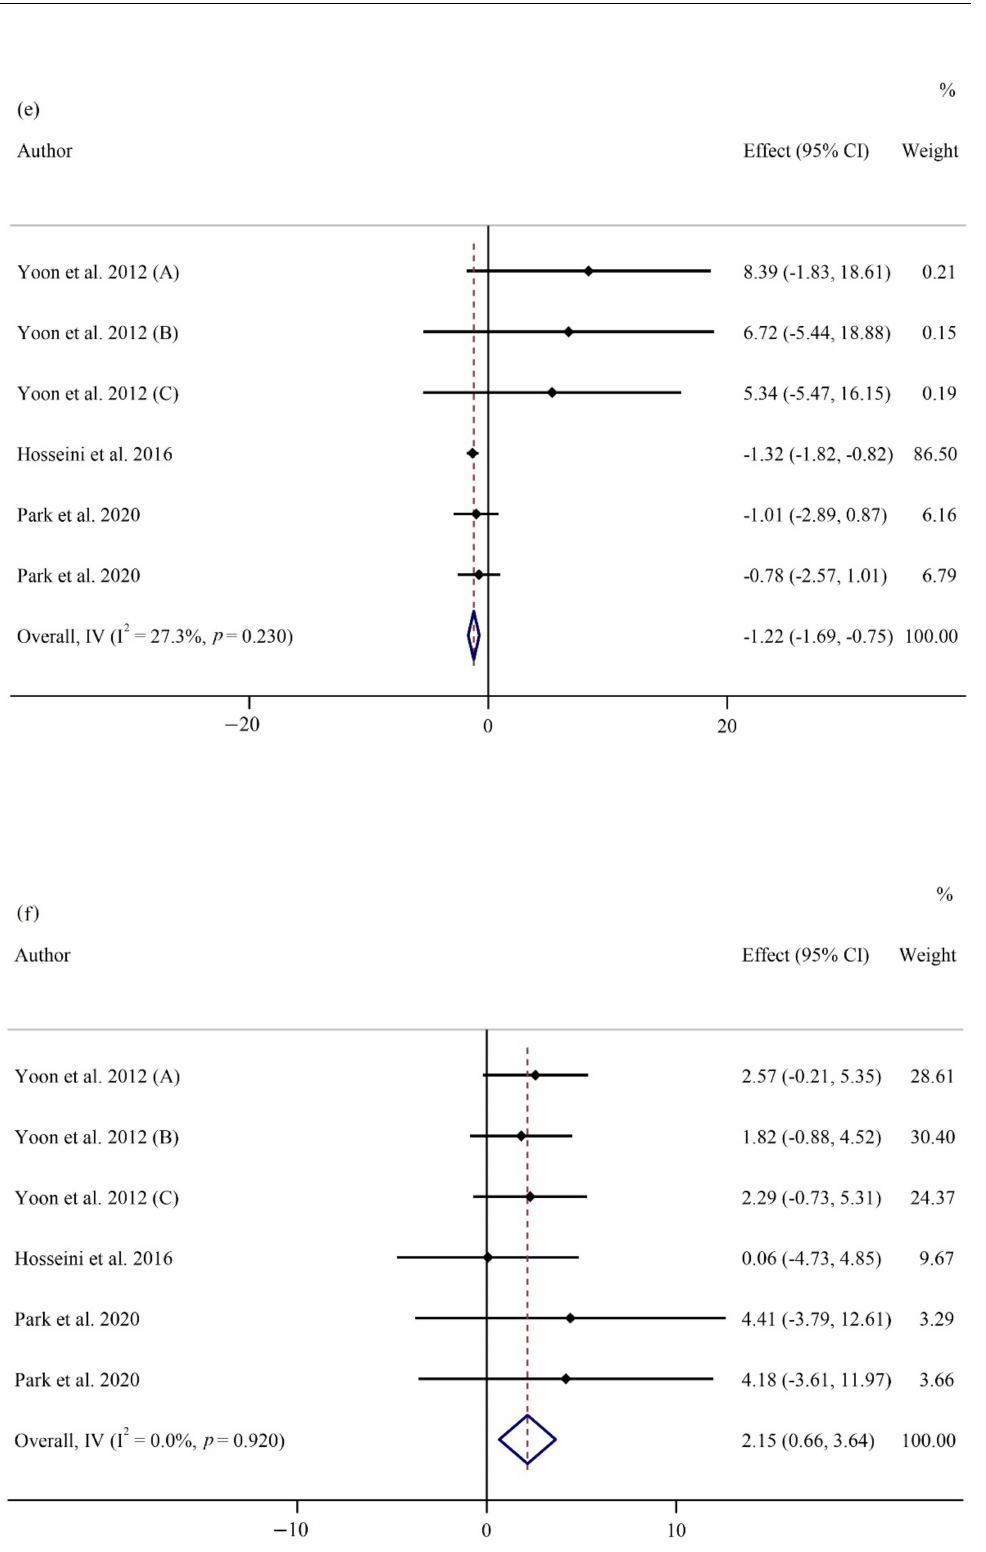
Figure 2. Forest plots of randomized controlled trials illustrating weighted mean difference (WMD) in biomarkers between the intervention and placebo groups for all eligible studies in overall analysis. ( a ) Fasting plasma glucose (FPG) [1,5,12,21,22,24–27,29,30,53,54,56–59]; ( b ) homeostatic model assessment for insulin resistance (HOMA-IR) [24–26,29,30,53,56,59]; ( c ) total cholesterol (TC) [1,5,22,25–27,30,53,54,57]; ( d ) heart rate (HR) [22,28,55]; ( e ) interleukin 6 (IL-6) [21,24,25,30]; ( f ) tumor necrosis factor- α (TNF- α )